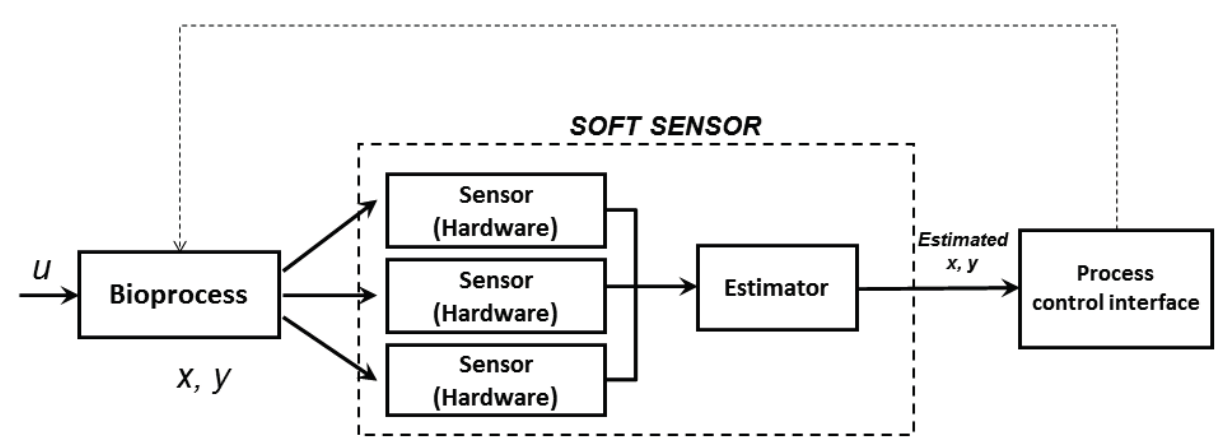
Figure 1. Basic principle of a soft